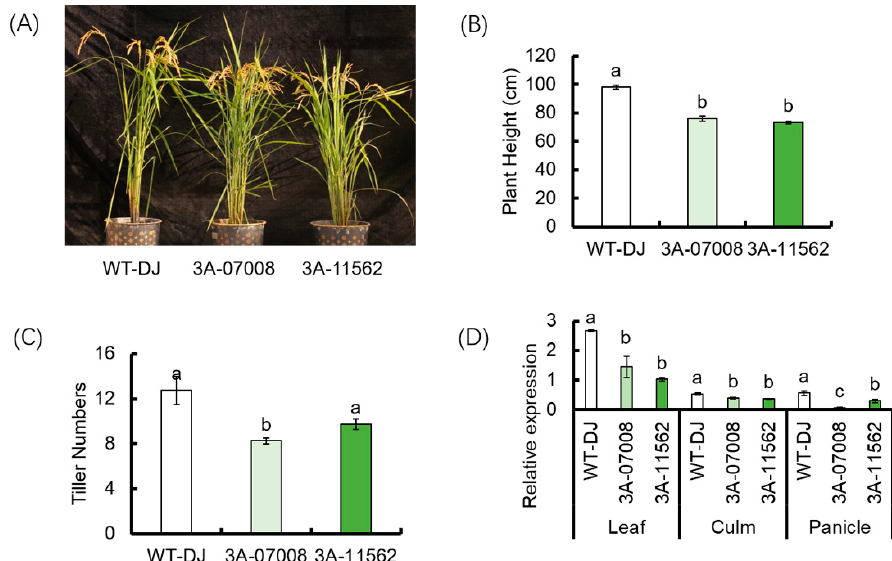
Figure 4. Characterization of the OsTBP2.2 mutant lines. ( A ) Phenotype of T-DNA insertion mutants of OsTBP2.2 (3A-07008 and 3A-11562) and the wild type (WT-DJ) under non-stress conditions. ( B ) Plant height of ostbp2.2 (3A-07008 and 3A-11562) and WT-DJ. ( C ) Tiller numbers of ostbp2.2 (3A-07008 and 3A-11562) and WT-DJ. ( D ) Real-time quantitative PCR analysis the expression of OsTBP2.2 in the leaf, culm and panicle of ostbp2.2 and WT-DJ. Error bars: SE ( n = 3). Significant differences between ostbp2.2 and WT-DJ are indicated by different letters. ( p < 0.05).